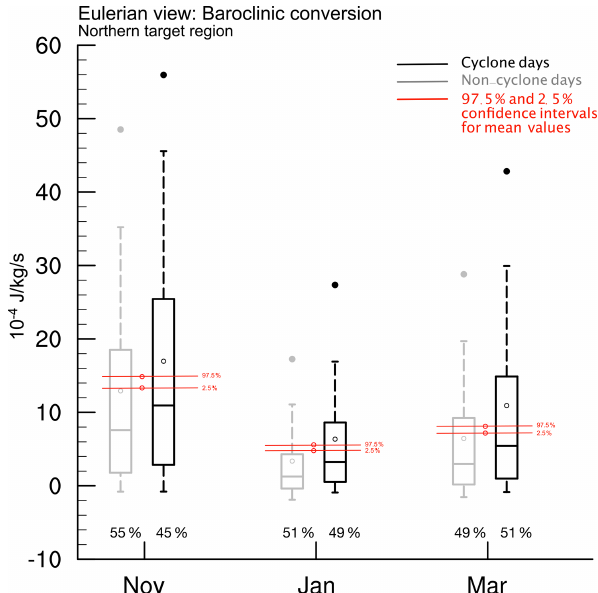
Figure 5. Box-and-whisker diagram of baroclinic conversion at 500hPa (10 − 4 Jkg − 1 s − 1 ) averaged over the northern target re- gion (gray box in Fig. 1) for days (black) with and (gray) with- out a surface cyclone affecting the target region (referred to as cy- clone and non-cyclone days). Whiskers span between the 10th and 90th percentiles and the box spans the 25th to 75th percentile range. Filled dots indicate the 95th percentile. Open circles indicate the mean value and horizontal lines the median value. The 2.5% and 97.5% confidence intervals of a statistical test (see text for details) are shown in red. Percentage values at the bottom indicate the frac- tion of days in each